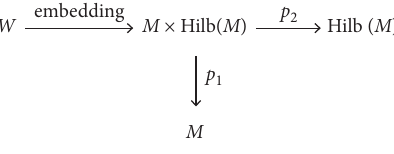
Figure 2: The deformation of C in M .